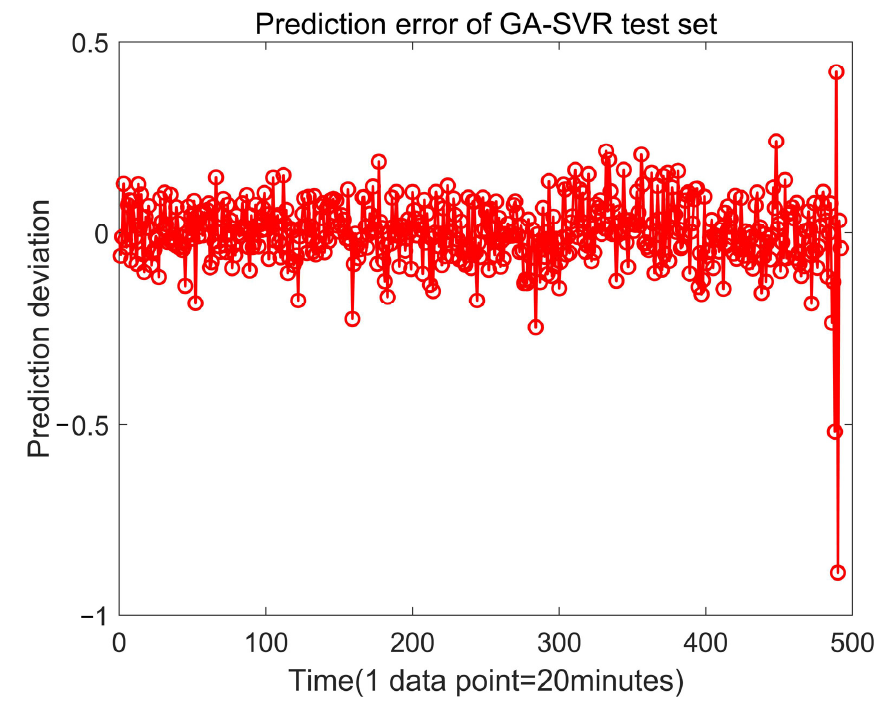
Figure 11. The prediction error of the test set by GA-SVR.